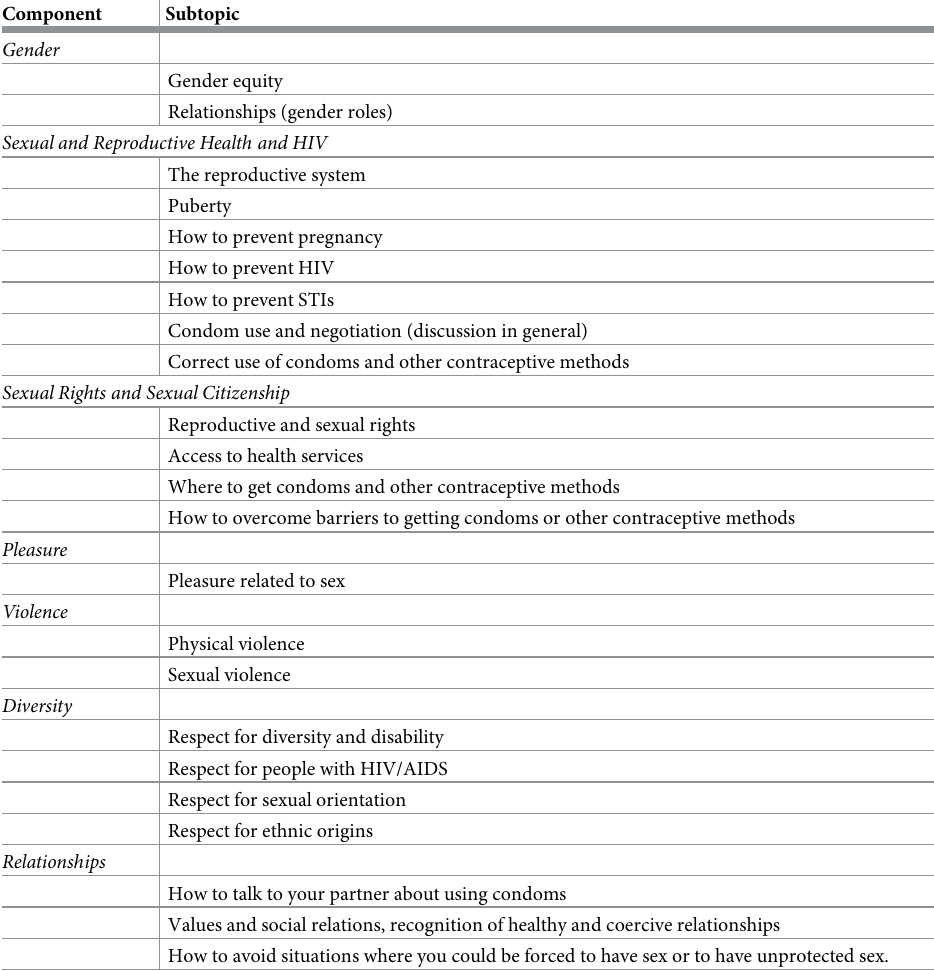
Table 1. Subtopics students were asked about to measure exposure to comprehensive sex education (CSE) topics in high-school students at any time during schooling, Mexico,